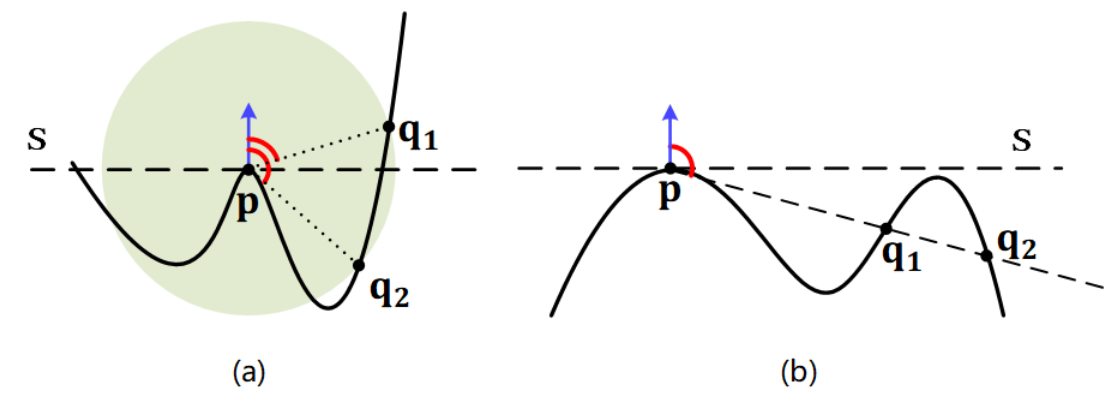
Figure 3. An illustration of information complementary inherent to the two attributes in LRF-Net. The two radius neighbors q 1 and q 2 of the keypoint p in ( a ) and ( b ) have different spatial locations. In ( a ), the two radius neighbors with the same distance value are distinguished by the surface variation angle attribute. In ( b ), their surface variation angle attribute values are similar, while they can be distinguished by the distance